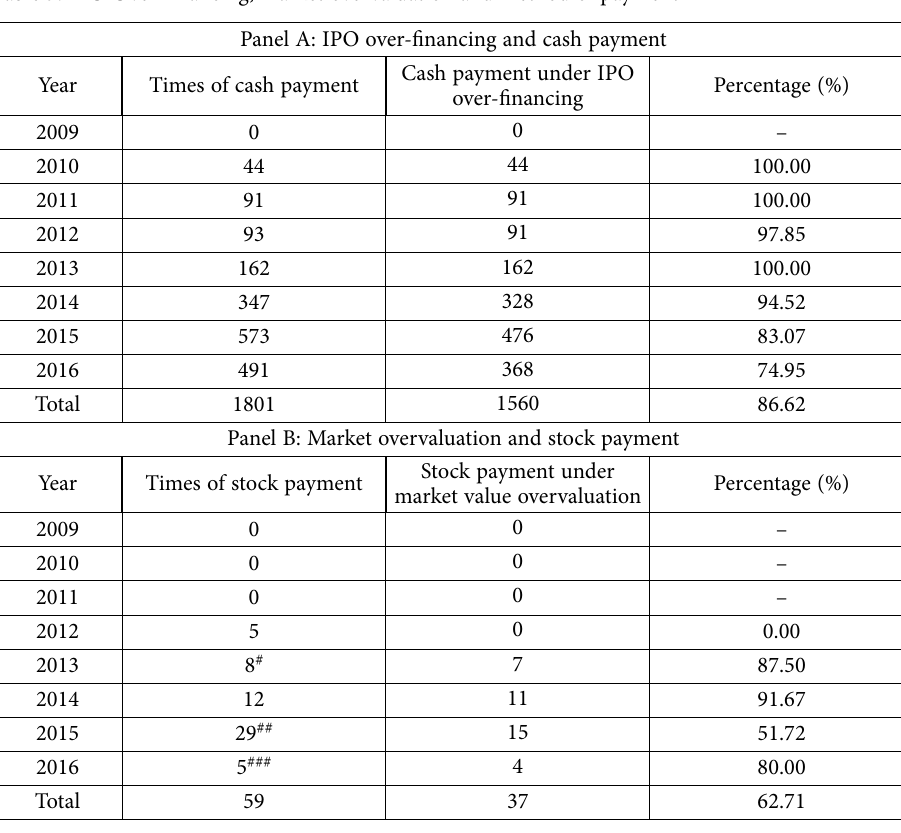
Table 7. IPO Over-financing, market overvaluation and method of payment Panel A: IPO over-financing and cash